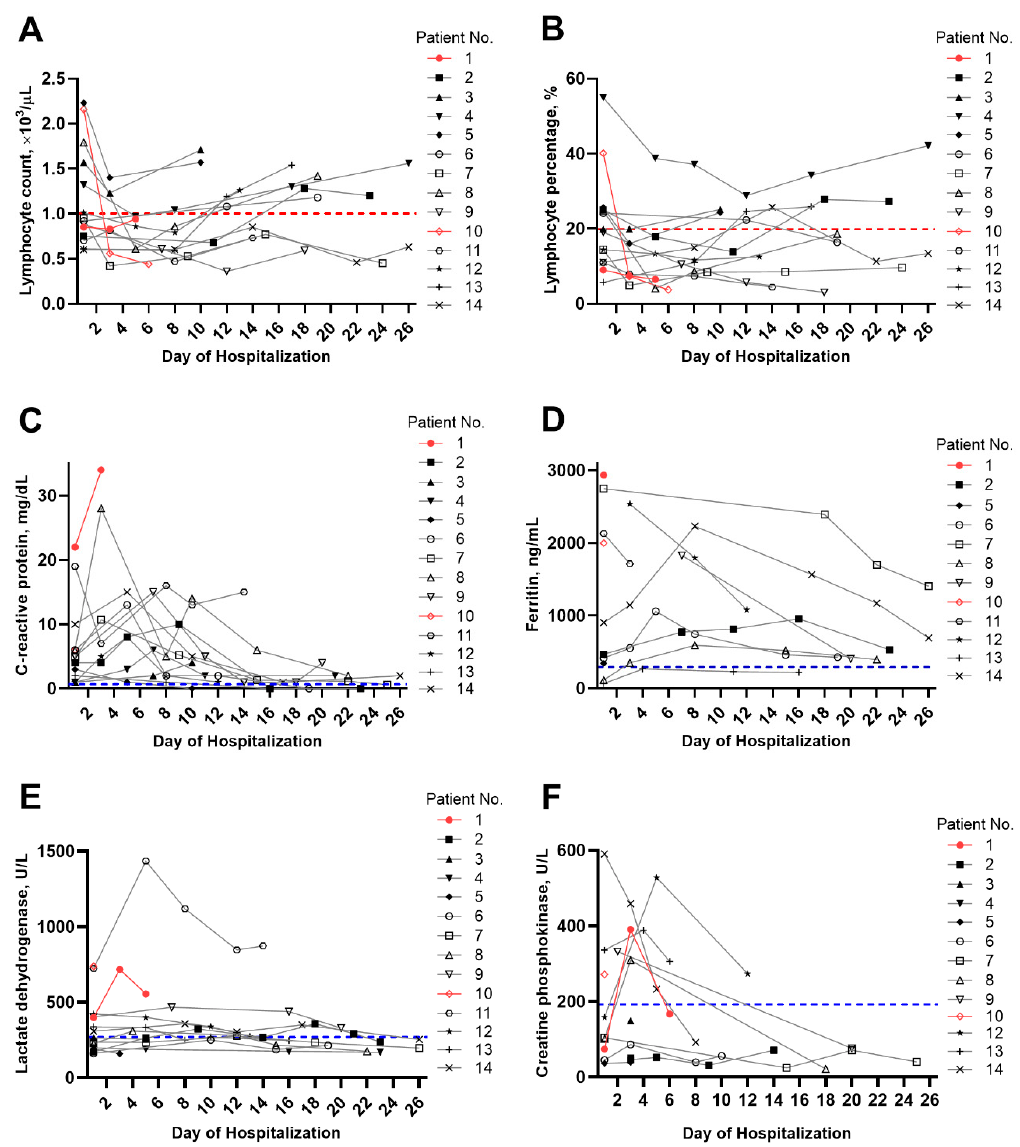
Figure 1. Temporal changes in laboratory markers in individual patients with end-stage renal disease and COVID-19. The temporal changes for ( A ) lymphocyte count, ( B ) lymphocyte percentage, ( C ) C-reactive protein, ( D ) ferritin, ( E ) lactate dehydrogenase, and ( F ) creatine phosphokinase. The red symbols and solid red lines indicate the results for patients who died. The dotted red lines indicate the lower limit of normal for lymphocyte count and lymphocyte percentage, while the dotted blue lines indicate the upper limit of normal for each